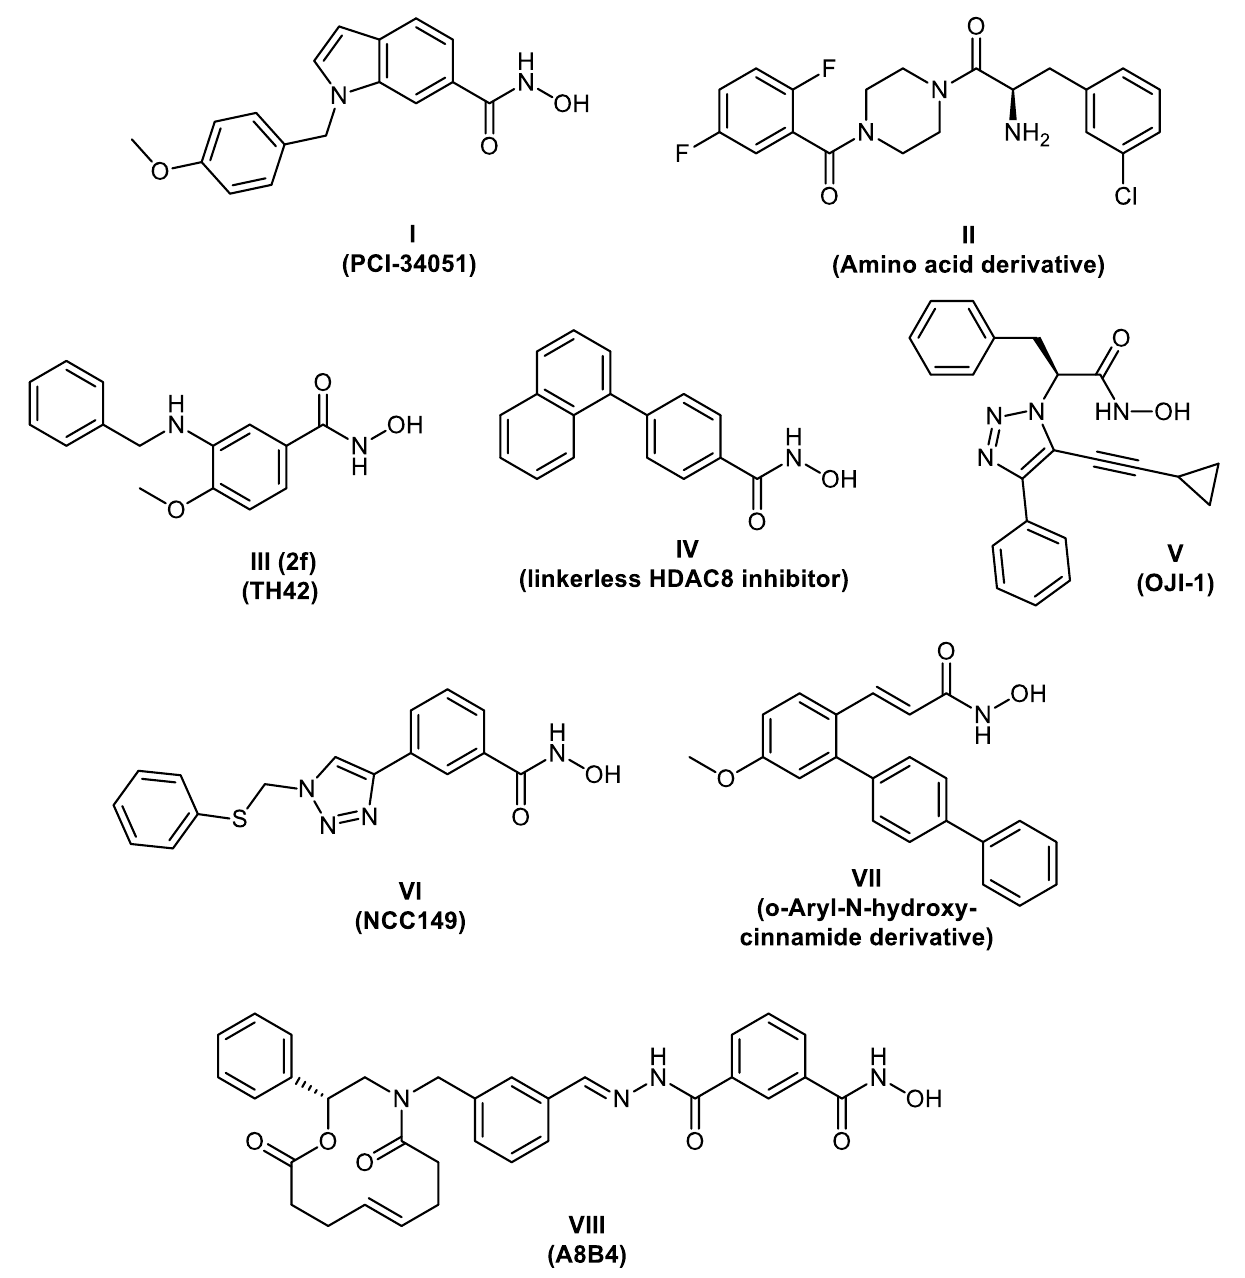
Figure 1. Chemical structures of reported HDAC8 inhibitors.